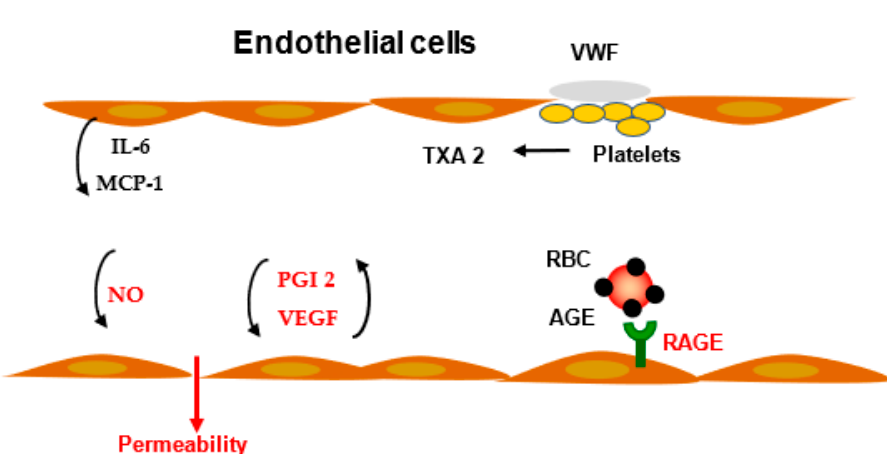
Figure 3. Modulation of vascular permeability and inflammation. Activated EC produced and released interleukin-6 (IL-6) and macrophage (monocyte) protein-1 (MCP-1) in inflammatory conditions. Advanced glycation end products (AGE), present on protein or red blood cell (RBC), bind to a specific receptor (RAGE), inducing a cascade of reactions, resulting in an increased vascular permeability. Nitric oxide (NO) is one of the mediators for vascular tone and vascular permeability. Prostacyclin (PGI 2) modulates vascular pressure and permeability. Activated platelets, after adhesion to the matrix and von Willebrand factor (VWF), release thromboxane A2 (TXA2), which contributes to permeability regulation.